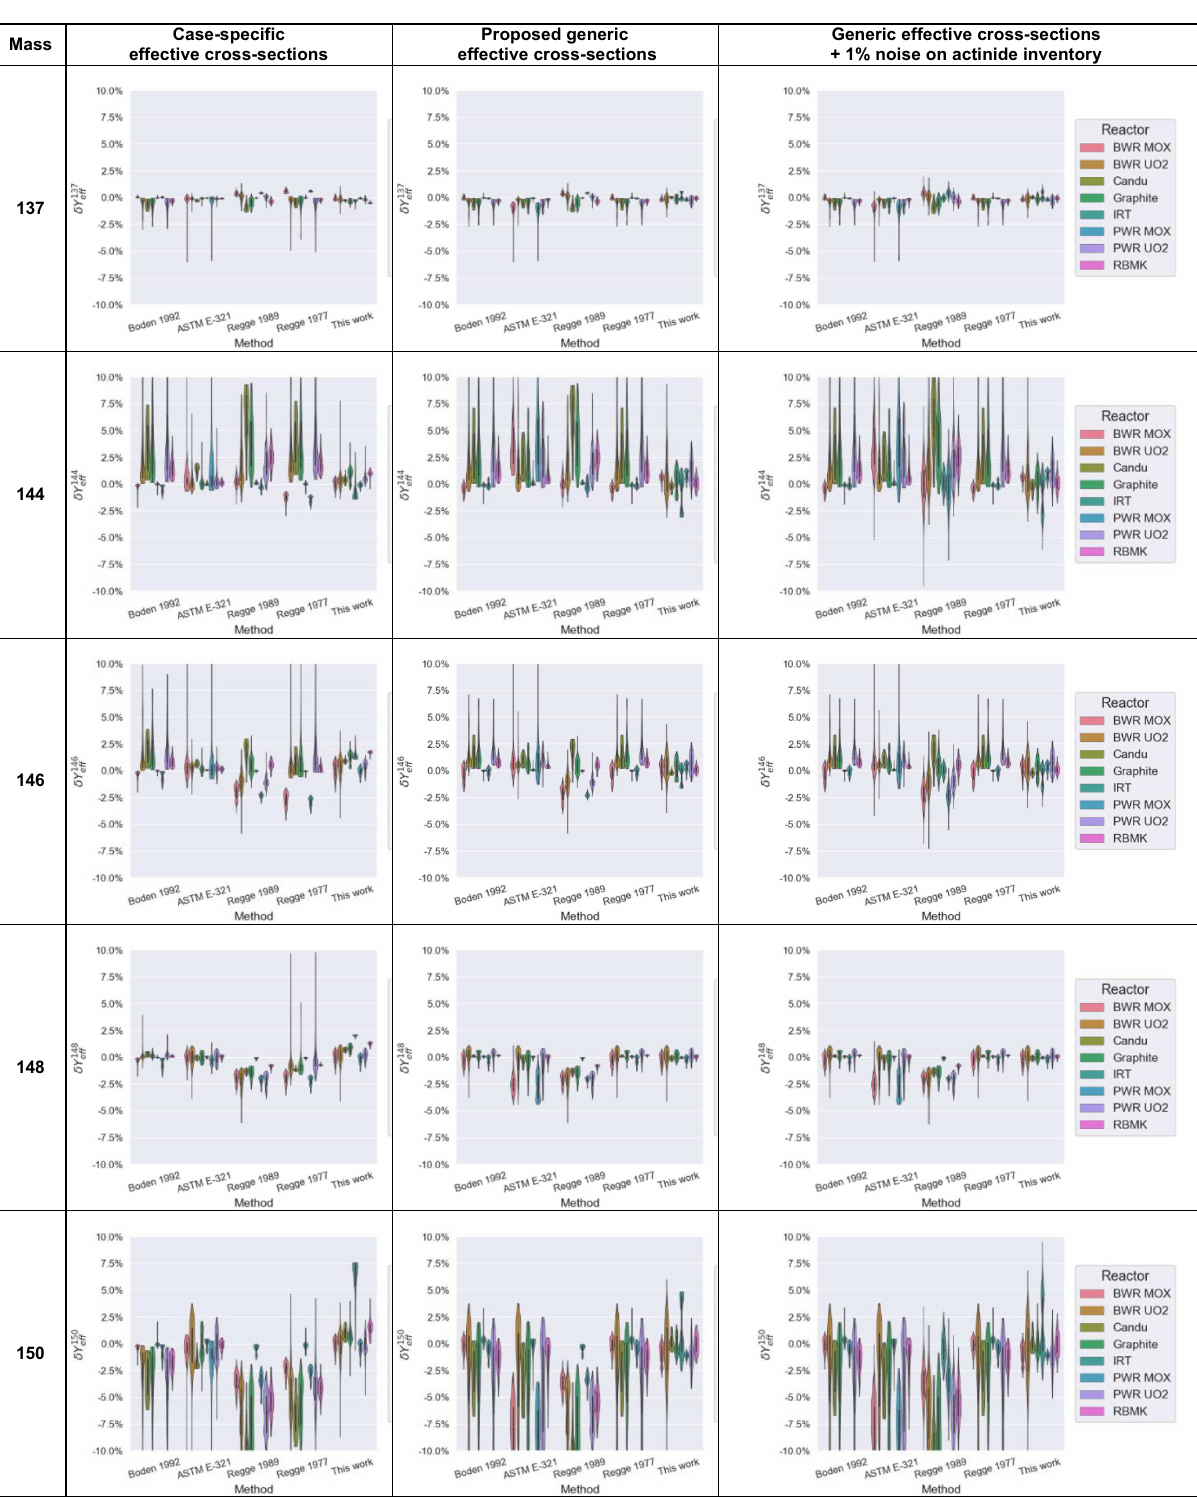
Fig. 5. Ratio of the irradiation-averaged fission yield values estimated by the different burnup determination methods, to the simulation-based irradiation-averaged fission yield values. The comparison offers an integral assessment of the distribution of fissions predicted by the different burnup determination methods, including the one proposed in this work. In the first column, the ORIGEN (calculated, case-specific) effective cross-section values are used. The second column illustrates the performance of the various methods, with the set of generic effective cross-sections as proposed in Table 2. The last column illustrates the sensitivity of the methods to scatter, which is simulated as 1% noise in the actinide inventory, assuming a normal